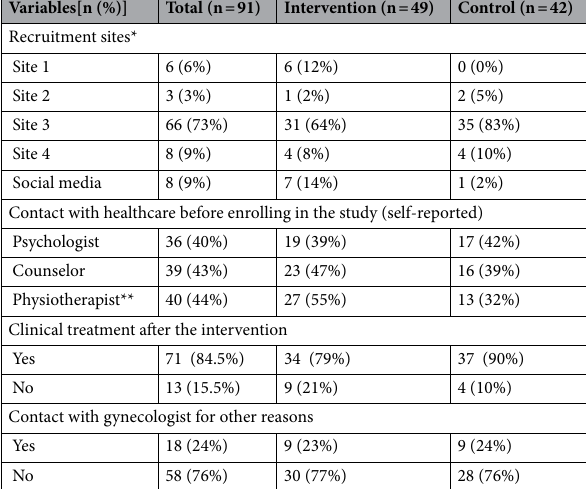
Visits related to provoked vulvodynia after intervention